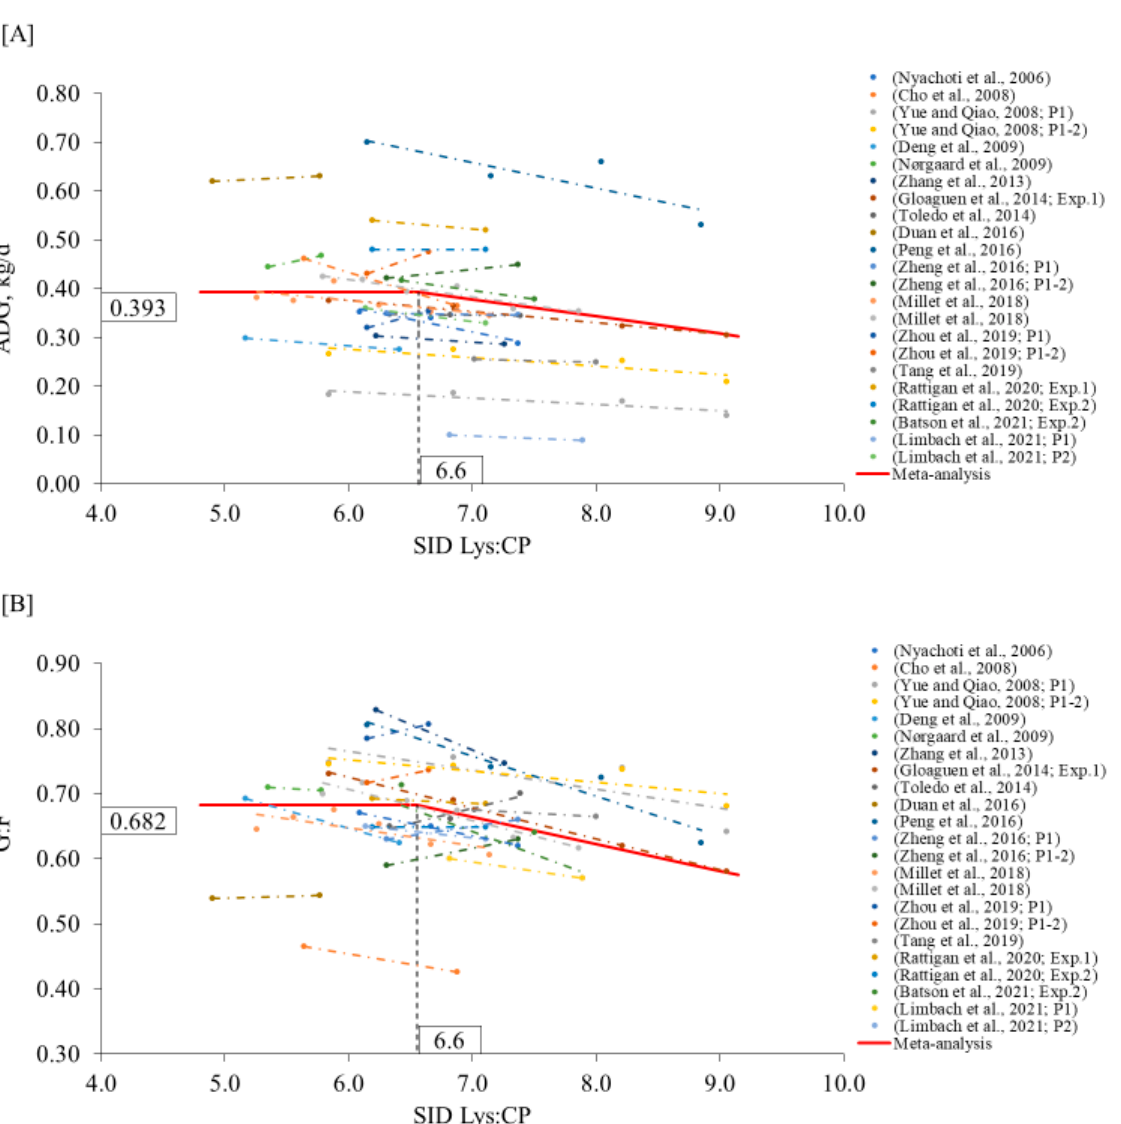
Figure 3. Changes in ADG ( A ) and G:F ( B ) in response to the ratio between standard ilea digestible Lys to crude protein (SID Lys:CP) in the nursery phase using a broken-line analysis. The equation for ADG was ADG = 0.393 + 0.035 × zl (R 2 = 0.98) and the breakpoint was SID Lys:CP ratio at 6.6% (95% CI: 5.9–7.2) when ADG was 0.393 kg/d. The p -value for the asymptote was <0.001, for the slope it